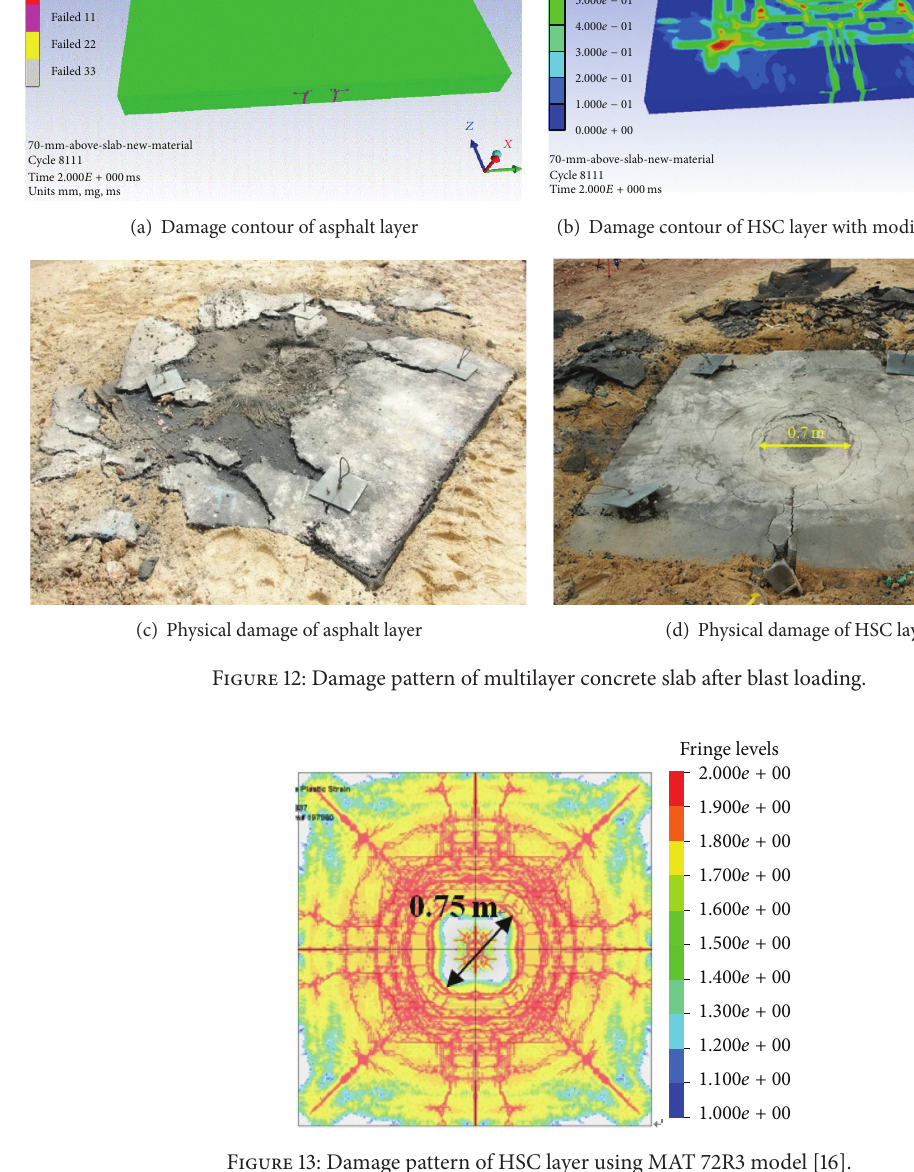
Figure 13: Damage pattern of HSC layer using MAT 72R3 model